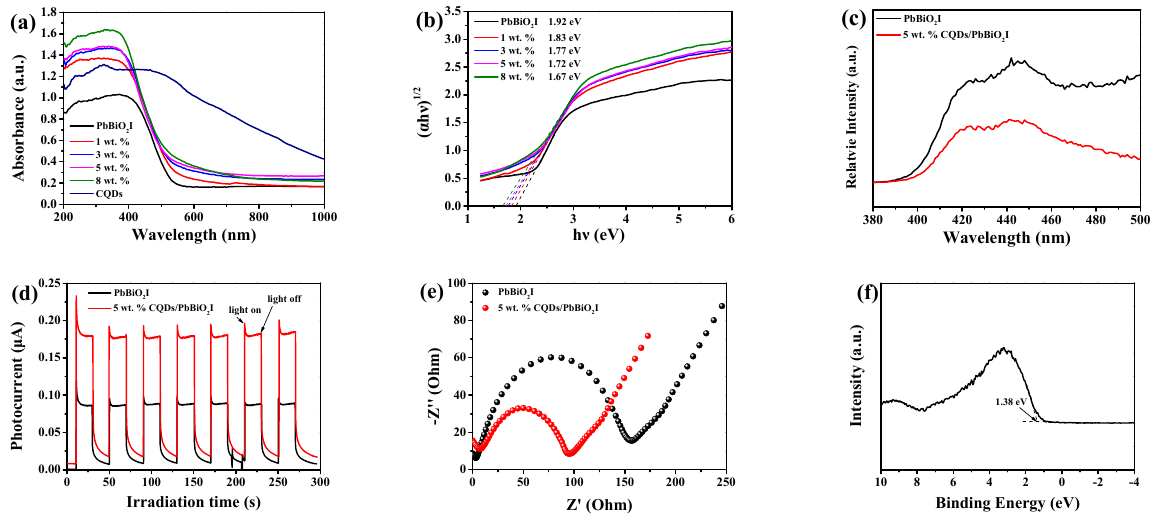
Figure 5. ( a ) UV-vis DRS of the acquired samples; ( b ) Bandgap of PbBiO 2 I and CQDs/PbBiO 2 I nanocomposite; ( c ) PL spectra, ( d ) transient photocurrent spectra, ( e ) EIS spectra of PbBiO 2 I and 5 wt.% CQDs/PbBiO 2 I; ( f ) XPS Valence-band spectra of PbBiO 2 I.